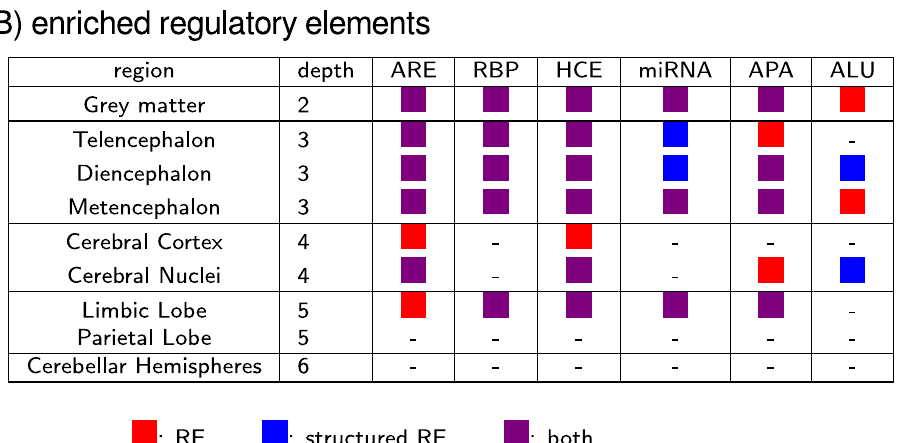
We assessed the similarity of motifs corresponding to two CRS by evaluating for which sequences of struc- tured REs they were predicted (Fig. 3). The overlap between the sequences of predicted instances was then used to compute a similarity score between 0 and 1. Sequences with predicted instances of motifs corresponding to 13 out of the 15 CRS overlap with at least one other of the 15 CRS. All 13 of these motifs contain purine-uracil tan- dem repeats ((RU) n repeats). Eight of these 13 motifs form a cluster of relatively AU-rich sequences (GC content < 0.3). Instances of these (RU) n repeat motifs were predicted for several REs of neuron related genes including neuron projection associated genes (Supplementary file S7): acyl-CoA synthetase long-chain family member 4 (ACSL4), plexin A1 (PLXNA1), tetraspanin 2 (TSPAN2), Ras associated (RalGDS/AF-6) and pleckstrin homol- ogy domains 1 (RAPH1) (Fig. 4A), and potassium voltage-gated channel subfamily H member 5 (KCNCH5). See ‘Supplementary text S1 - Instances of RNA secondary structure motifs’ for additional information about CRS instances in specific genes. The two remaining CRS motifs, which do not overlap with the other thirteen motifs, were each found in RBP binding sites of three different genes that were differentially expressed in gray matter and in the case of CRS motif M1146447 also differentially expressed inside the metencephalon ((Fig. 4B, Supplementary text S1, Figs S2 and 3C). Instances of CRS motif M1146447 were predicted in the 3 ′ -UTRs of ER lipid raft associated 2 (ERLIN2), FK506 binding protein 5 (FKBP5) and sphingosine kinase 2 (SPHK2).